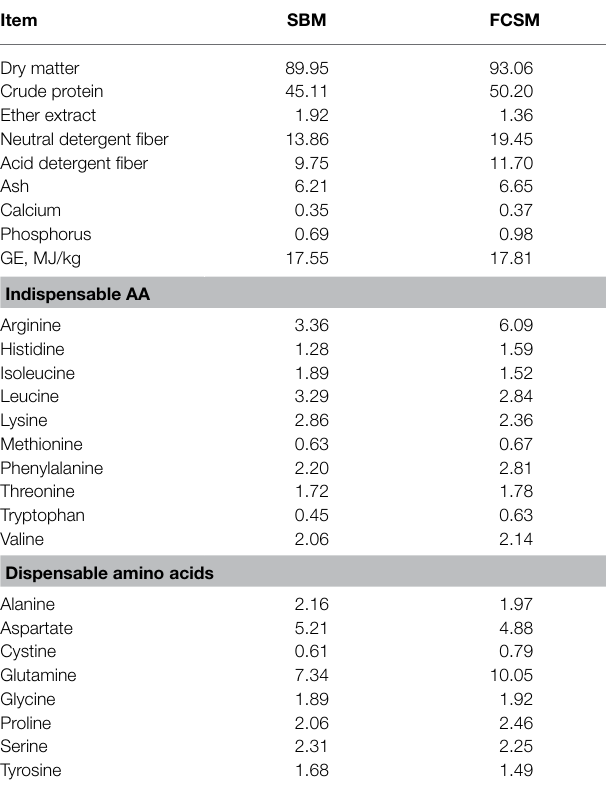
TABLE 2 | Ingredients composition and nutrient levels of the experimental diets (%, as-fed basis). Ingredients